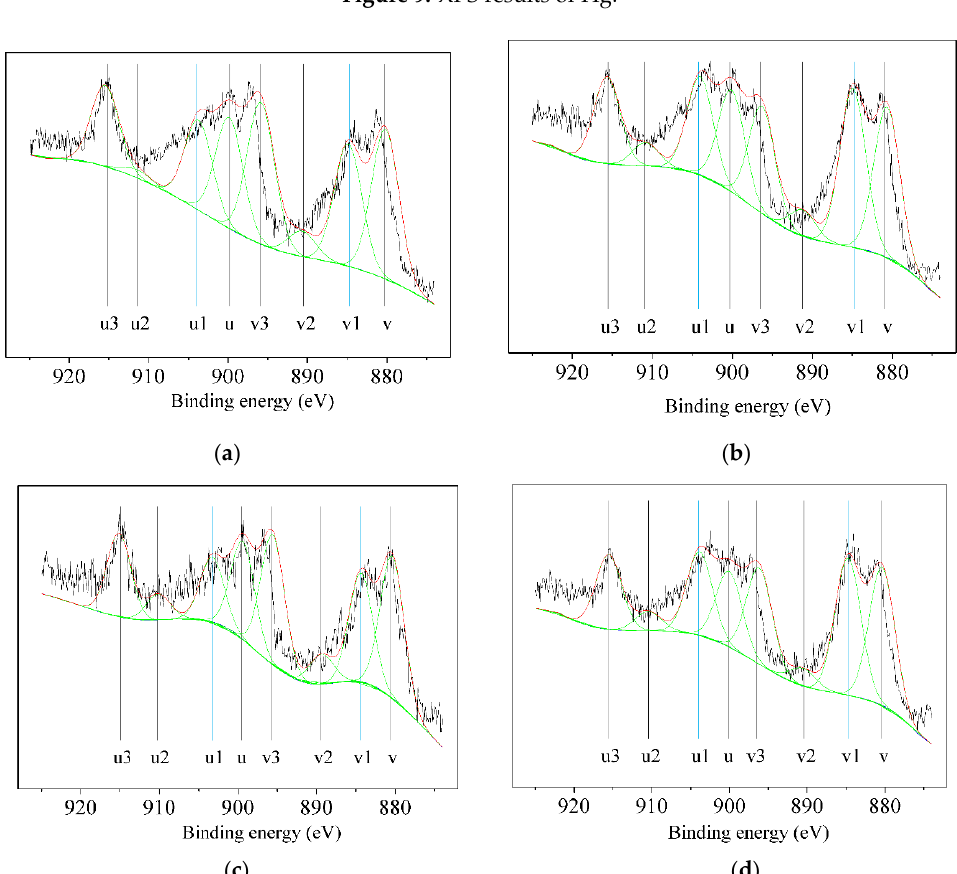
Figure 9. XPS results of Hg.